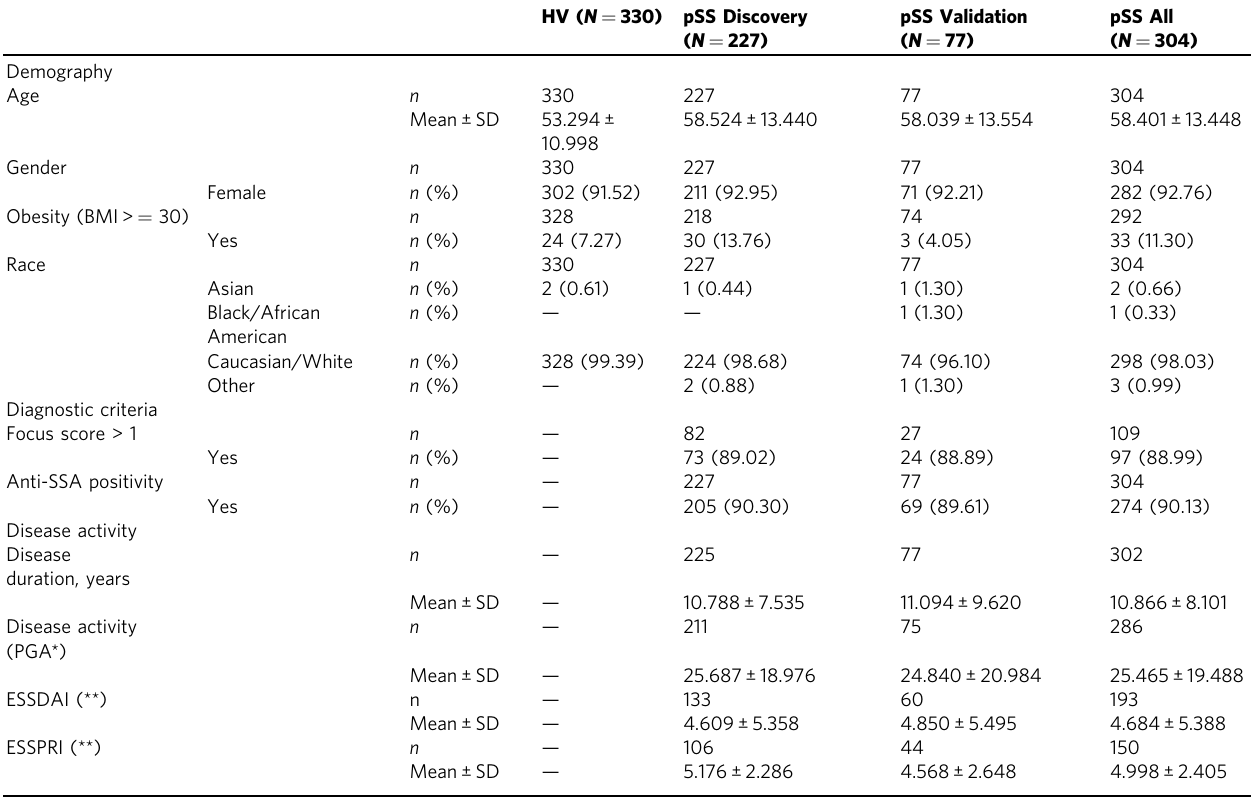
Table 1 Healthy volunteers (HV) and Primary Sjögren ’ s syndrome (pSS) patient